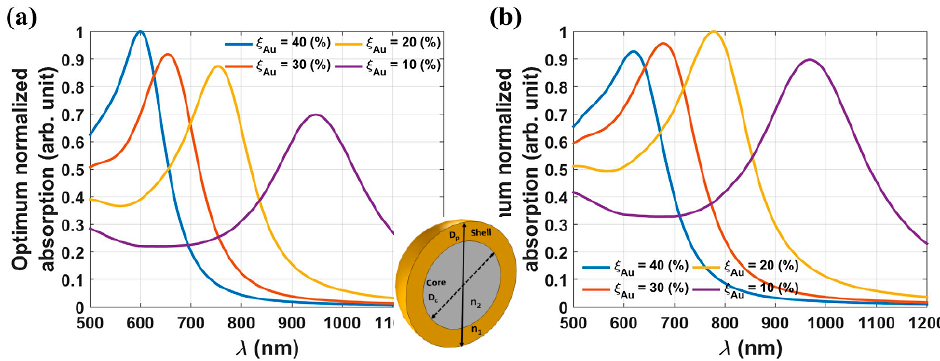
Figure 17. Parametric analysis of optimum normalized absorption vs. λ for two different sized Fe 3 O 4 @Au NPS with various shell-to-radius ratios ξ Au ( a ) D p = 60 nm, ( b ) D p = 100 nm. Reproduced with permission from [87].